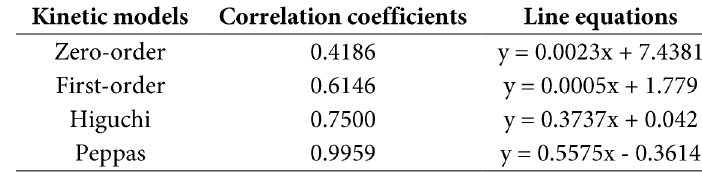
Table 1. Simulated equations and correlation coefficients of release curves for different kinetic